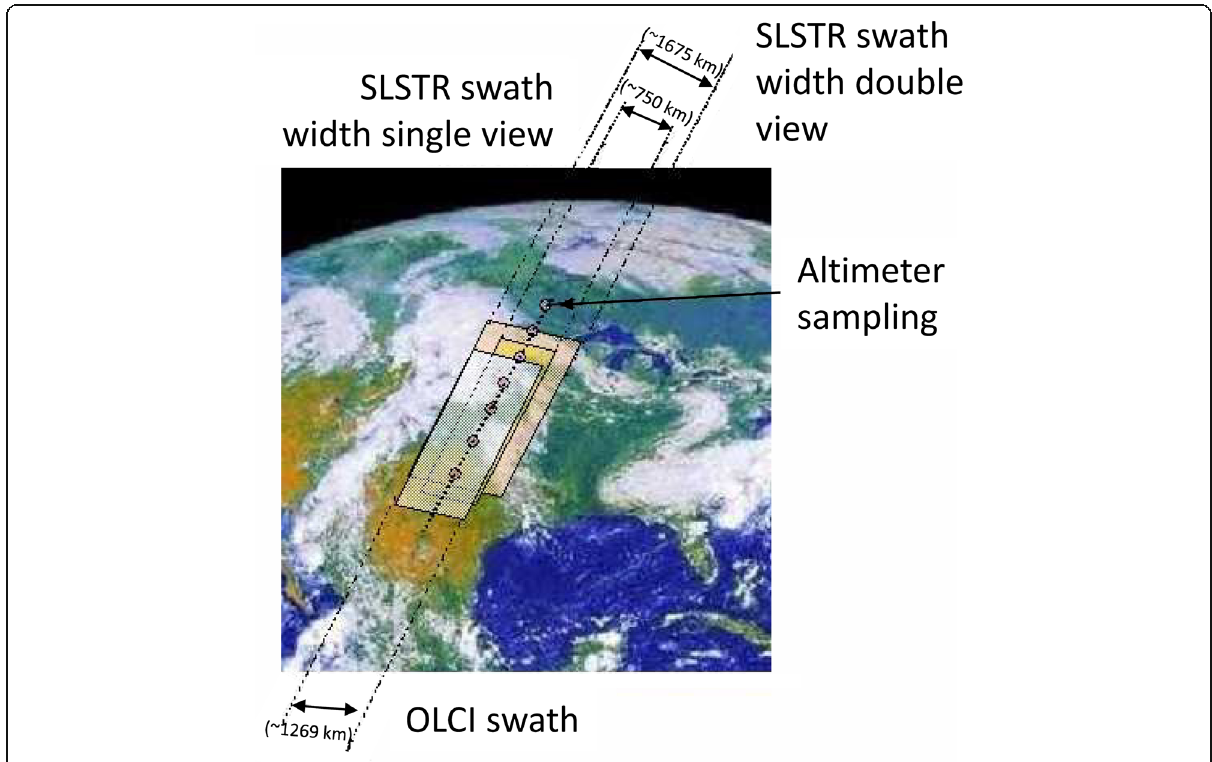
Fig. 10 The Sentinel-3 ground track acquisition geometry showing co-registered segments of SLSTR and OLCI imaging sensors. Figure derived from